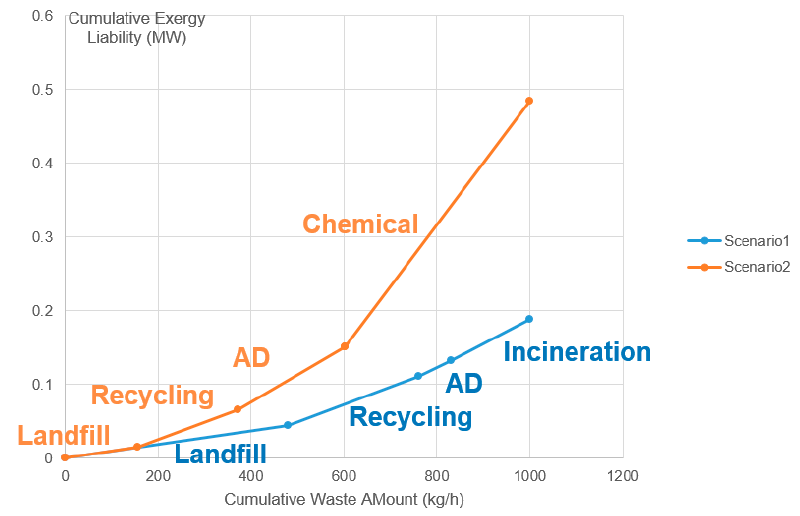
Figure 11. Composite Curves for the exergy liabilities of the MSW treatment under comparison.